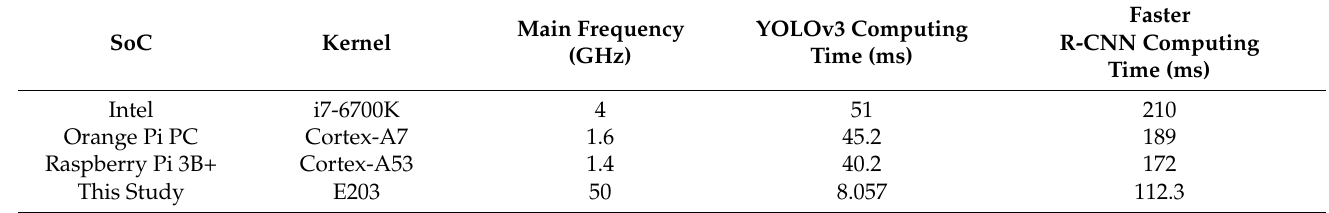
Table 5. Comparison between a general-purpose CPU and a high-performance CPU.